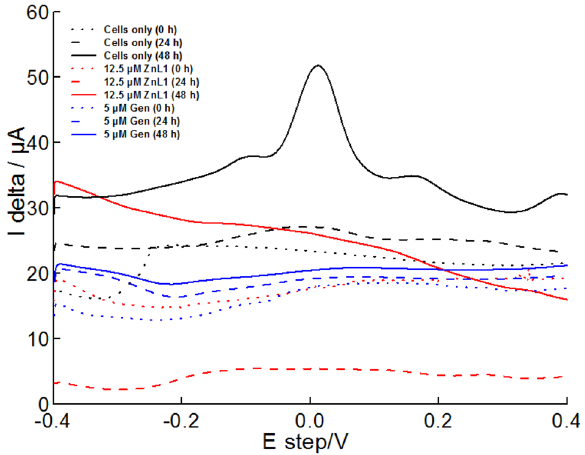
Figure 7. Electrochemical responses of A. baumannii cells treated with ZnL1 and Gen at MIC. Differential pulse voltammetry analyses of treated and untreated A. baumannii biofilms with up to 48 h